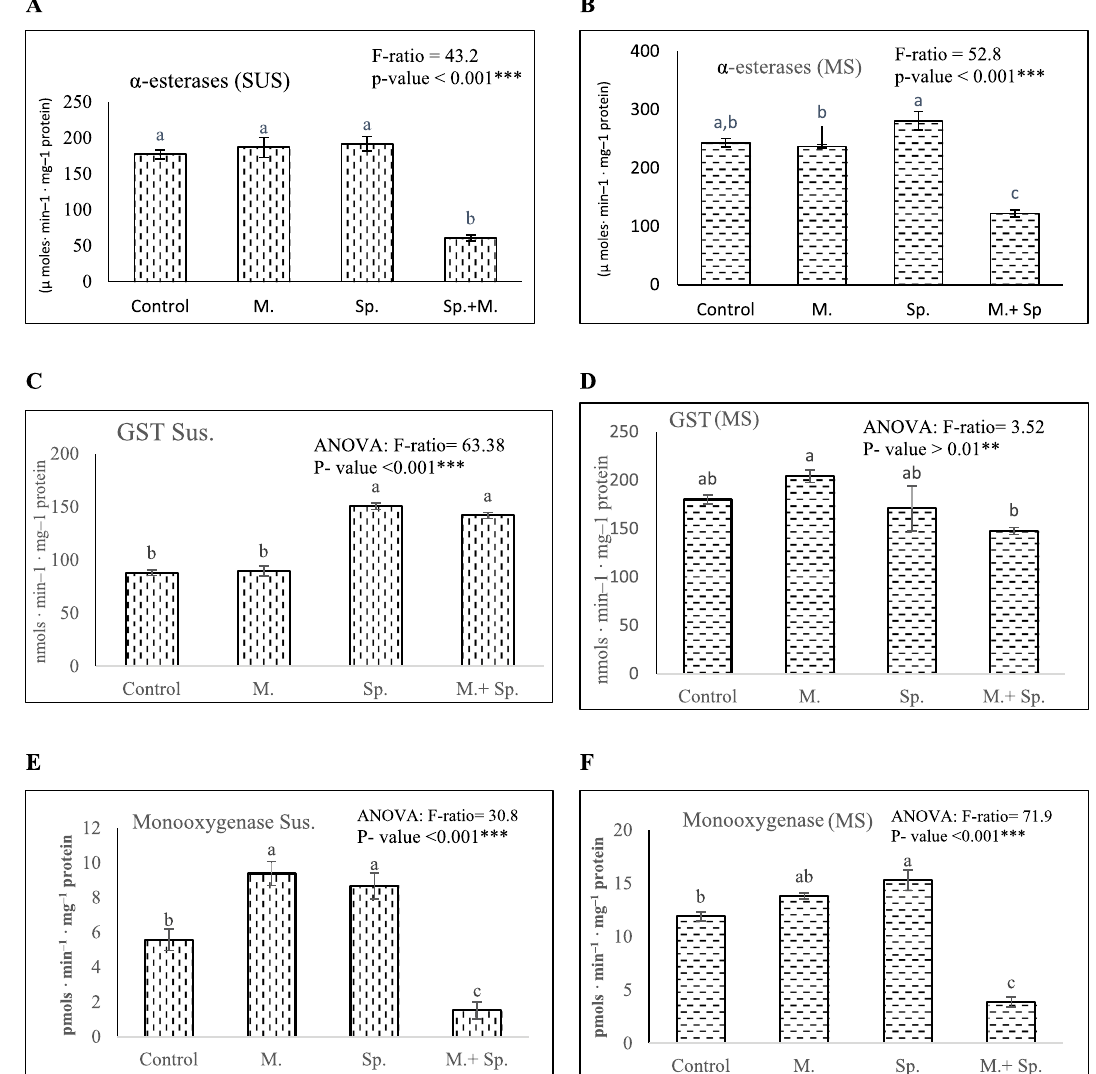
Figure 2. Enzymes specific activity 96 h. post-treatments with LC 25 of Spinetoram (Sp), LC 25 of Methoxyfenozide (M), or LC 25 : LC 25 values of M + Sp on the susceptible (SUS) and resistance (MS) strains of Spodoptera littoralis , respectively. ( A ), and ( B ): α-esterase activity, ( C ) and ( D ): GST activity, and ( E ) and ( F ): Monooxygenase activity. Values represent mean ± standard error. Means followed by different letters are significantly different according to Tukey’s multiple range comparison ( P < 0.01). F-ratio and p -values are calculated with ANOVA